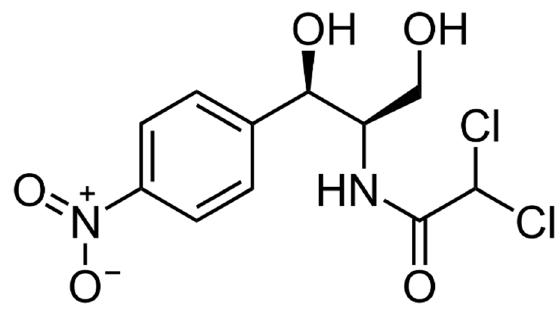
Figure 1. The structural formula of chloramphenicol.